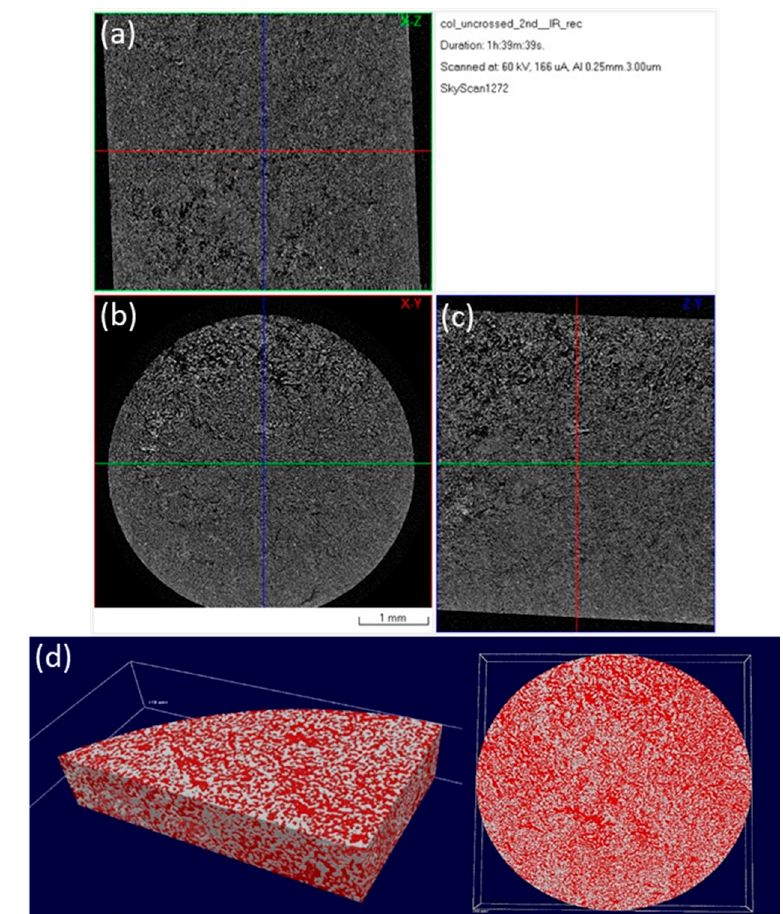
Figure 6. Micro-CT images of a 3D hybrid scaffold without crosslinking: reconstructed results visualized as a set of orthogonal slices crossed at selected points ( a ) XZ cross section, ( b ) XY cross section (perpendicular to Z axis of the specimen), ( c ) ZY cross section; ( d ) 3D surface rendered model from micro-CT scan presenting internal porosity (red) in specimen volume (white).